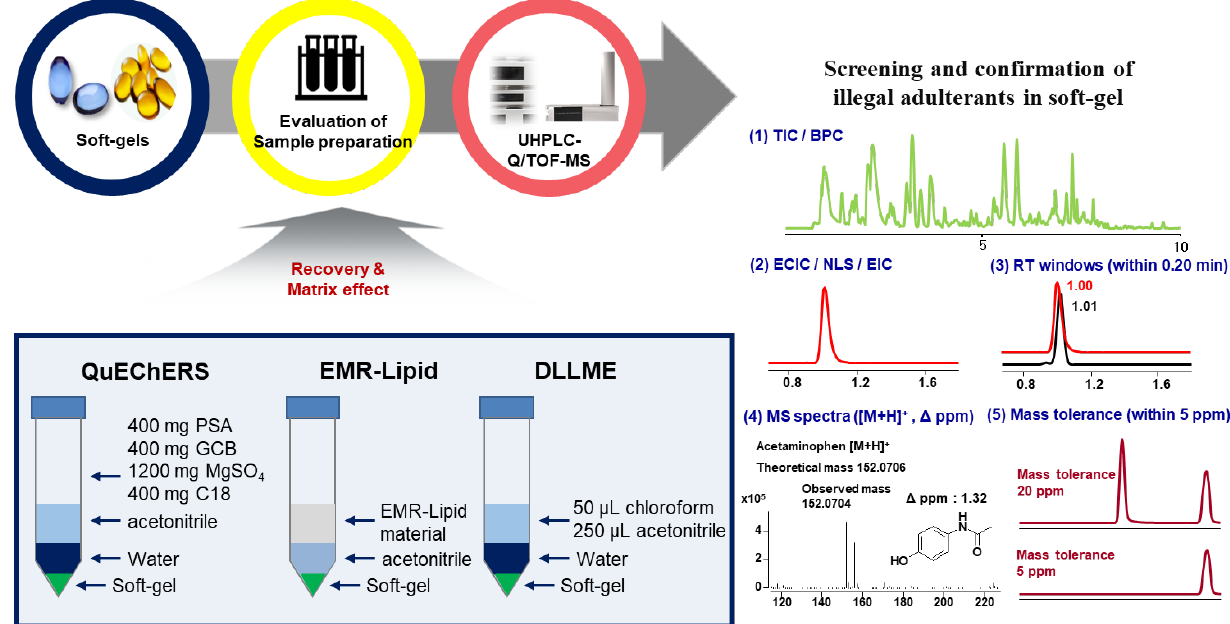
Figure 1. Analytical flow for screening of 92 illegal adulterants in soft-gel type dietary supplements.